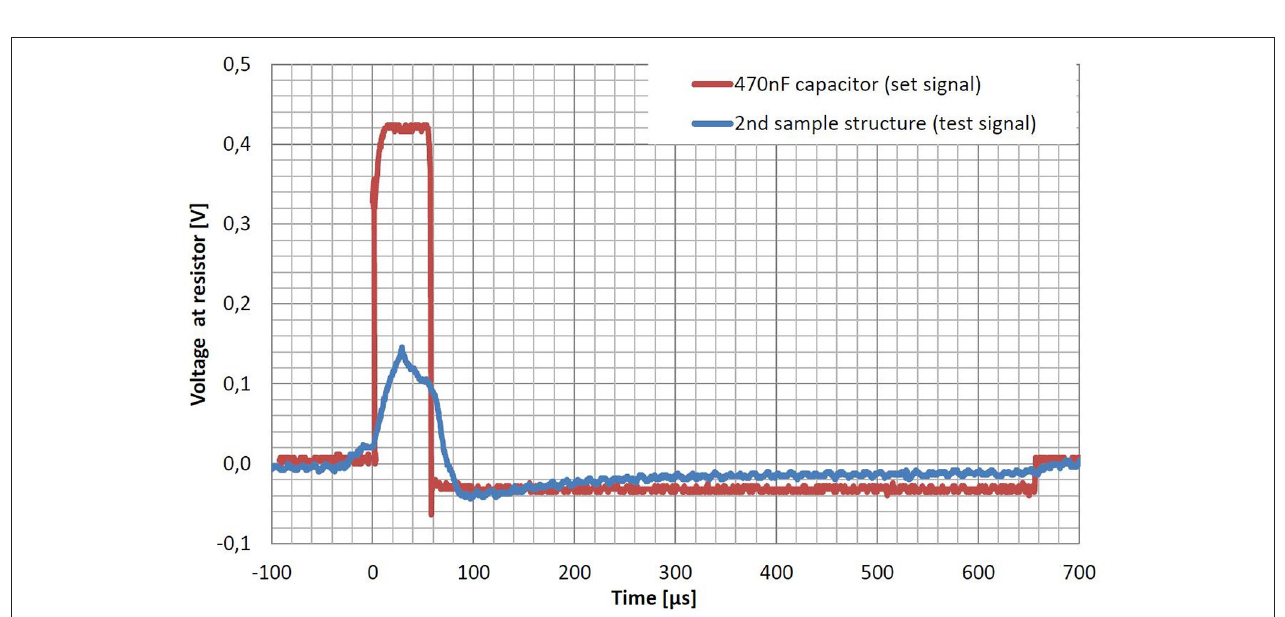
FIGURE 6 | Voltage of the transmitted stimulation signals using the three parallel capacitors of the second test structure (test signal) compared to the one using a common 470nF capacitor (set signal). DBS implant electronics were connected in series to one of the two capacitors and a resistor of 1 k (cid:127) simulating the tissue resistance. Stimulation parameters were a frequency of 130Hz, a current of 0.1mA and a pulse width of 60 µ s for the positive pulse followed by a negative pulse of 600 µ s and a tenth of the current. The extremely small capacity of about 170pF of the sample structure made it necessary to use a current divider with a factor of 1000 to lower the current through the resistance and the capacitors. Both graphs show averages over 128 samples to reduce noise. The amplitude of the test signal only reaches 34% of the one from the set signal. Moreover the shape is strongly deformed due to saturation effects of the capacity, which is too small. A possible shift between the two graphs is due to different trigger